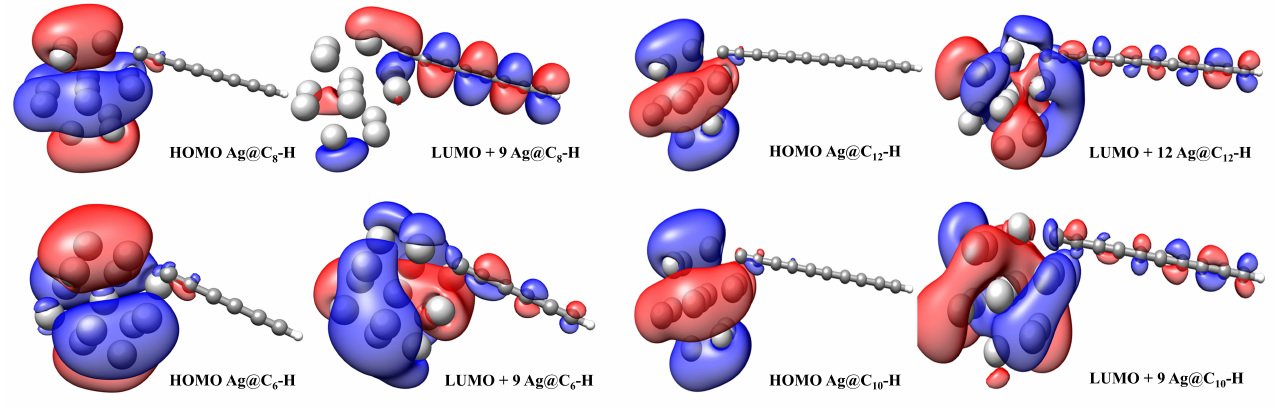
Figure 9. Electronic transitions of Ag@C 2 n –H at the TD-M062X/6-311+G(d,p)/LANL2DZ level.